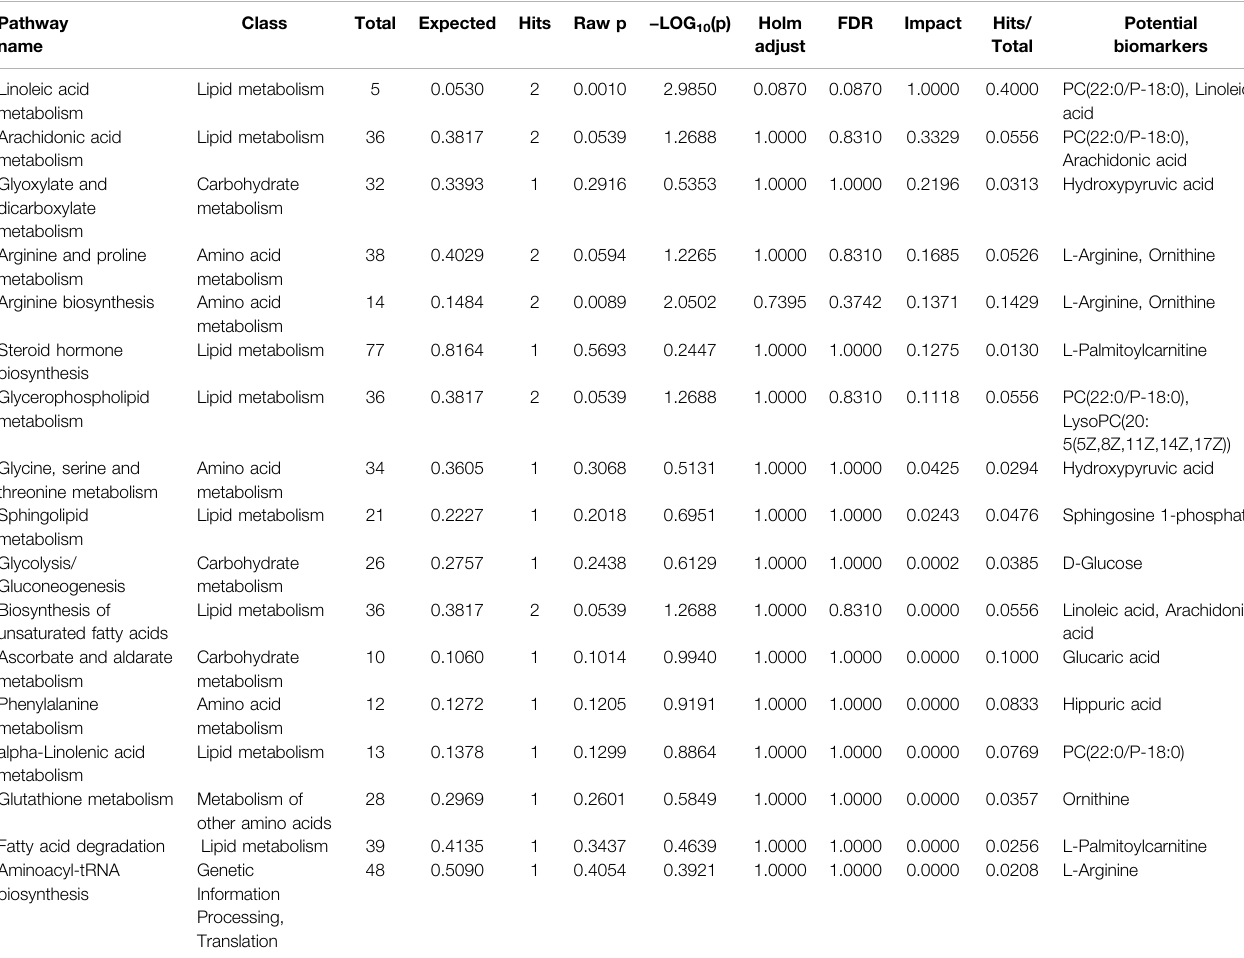
TABLE 2 | Metabolic pathway analysis based on